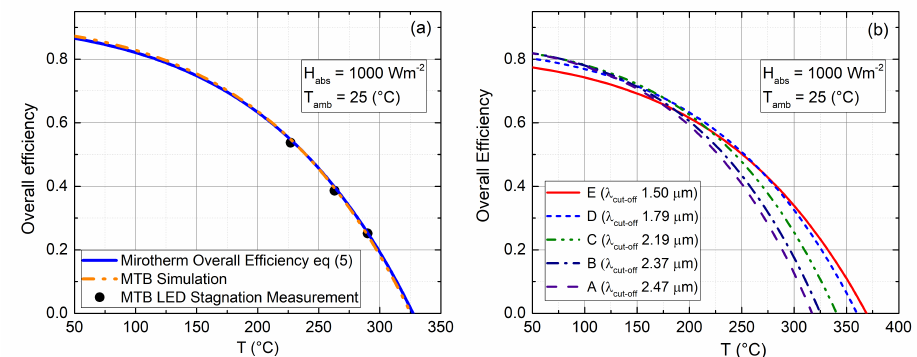
Figure 6. ( a ) Overall efficiency versus Absorber temperature T ( ◦ C): Mini-Test-Box (MTB) simu- lated efficiency (orange, dash dot), Led Measured MTB efficiency (black dots), Mirotherm ® overall efficiency calculated using Equation (8) (blue solid line). ( b ) Overall efficiency calculated using Equation (8) for coating having cut-off as reported in Table 1 (see